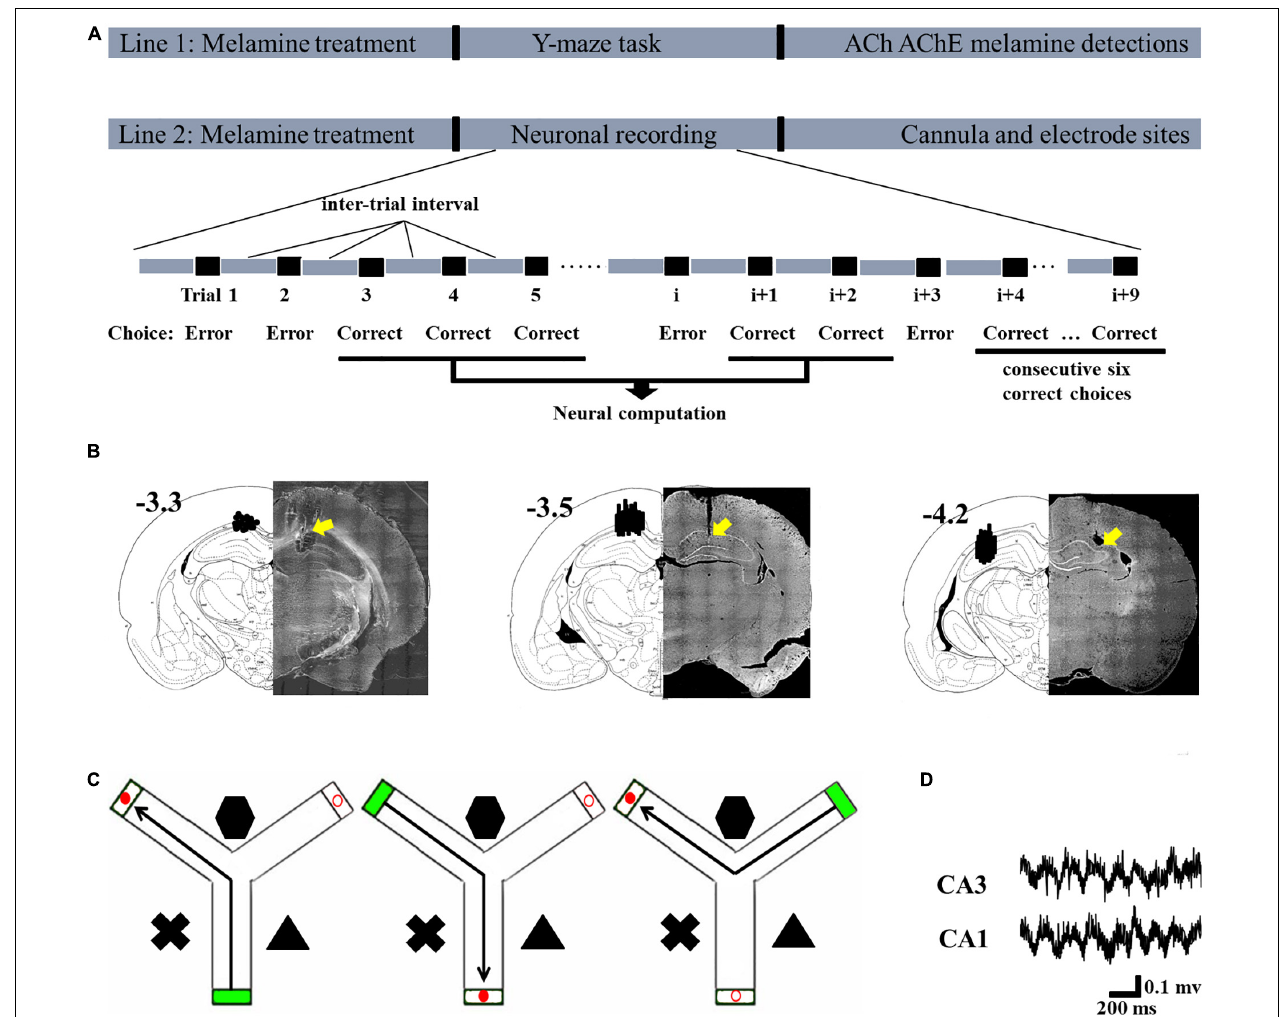
FIGURE 1 | Schematic describing the experimental workflow and schematic representations of the cannula and electrode sites. (A) In Line 1, following modeling, the rats in each group were tested in the Y-maze task and their hippocampi were collected to assess the levels of acetylcholine (ACh), acetylcholinesterase (AChE), and melamine. In Line 2, following modeling, neuronal recording was conducted. The signal during the correct choices, excluding the inter-trial interval, was selected for statistical analysis. Since this study was focused on the learning process and not the performance after sufficient training, the signal during the last six correct trials was not included in the statistical analysis. After the recording, the placements of the cannulae and electrodes were verified. (B) Schematic representation of the cannula placements ( left , –3.3) and electrode placements presented for CA1 ( middle , –3.5) and CA3 ( right , –4.2). (C) Schematic illustrations of the correct choice in the Y-maze task. Green box indicates the start arm; red solid circular indicates the correct (reward) arm; red hollow circular indicates the incorrect arm. (D) Representative local field potential (LFP) of the CA1 and CA3 regions during the correct